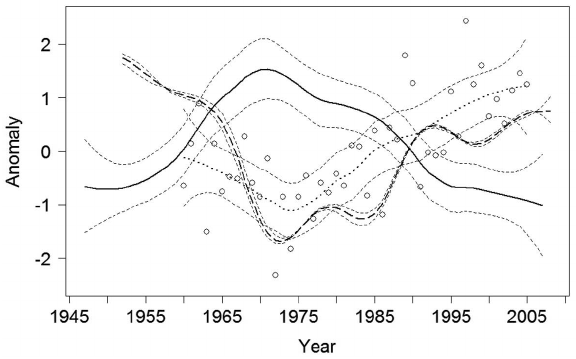
Fig . 7. – Long-term trends in sardine L (continuous line) in 1947- 50 2007, condition (dashed line) in 1952-2007 and sea surface tem- perature (SST, black symbols and dotted line) in 1960-2005. All trends are presented as anomalies from the long-term mean. Trends in L and SST are represented by a loess smoother with a span 50 of 0.5. Mean SST values are calculated from ICOADS at 41°30´N latitude and 9°30´W longitude (northern Portugal). The trend in condition corresponds to predicted values for a 17 cm sardine of the generalized additive model fit to the percentage of fat individuals (see Table 2). Thin dashed lines show ±2 standard